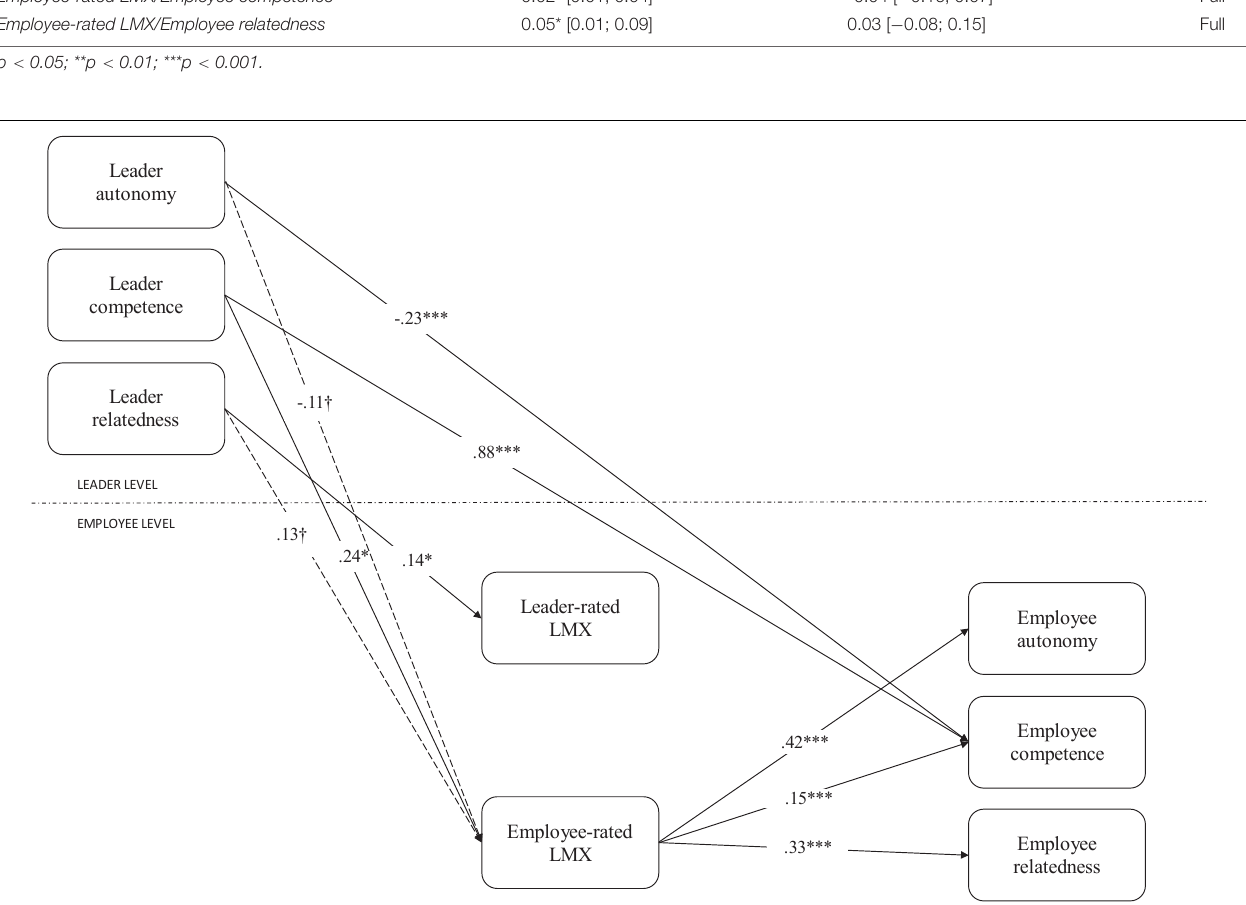
FIGURE 3 | Hierarchical regressions per psychological need. † p < 0.10; * p < 0.05; *** p <